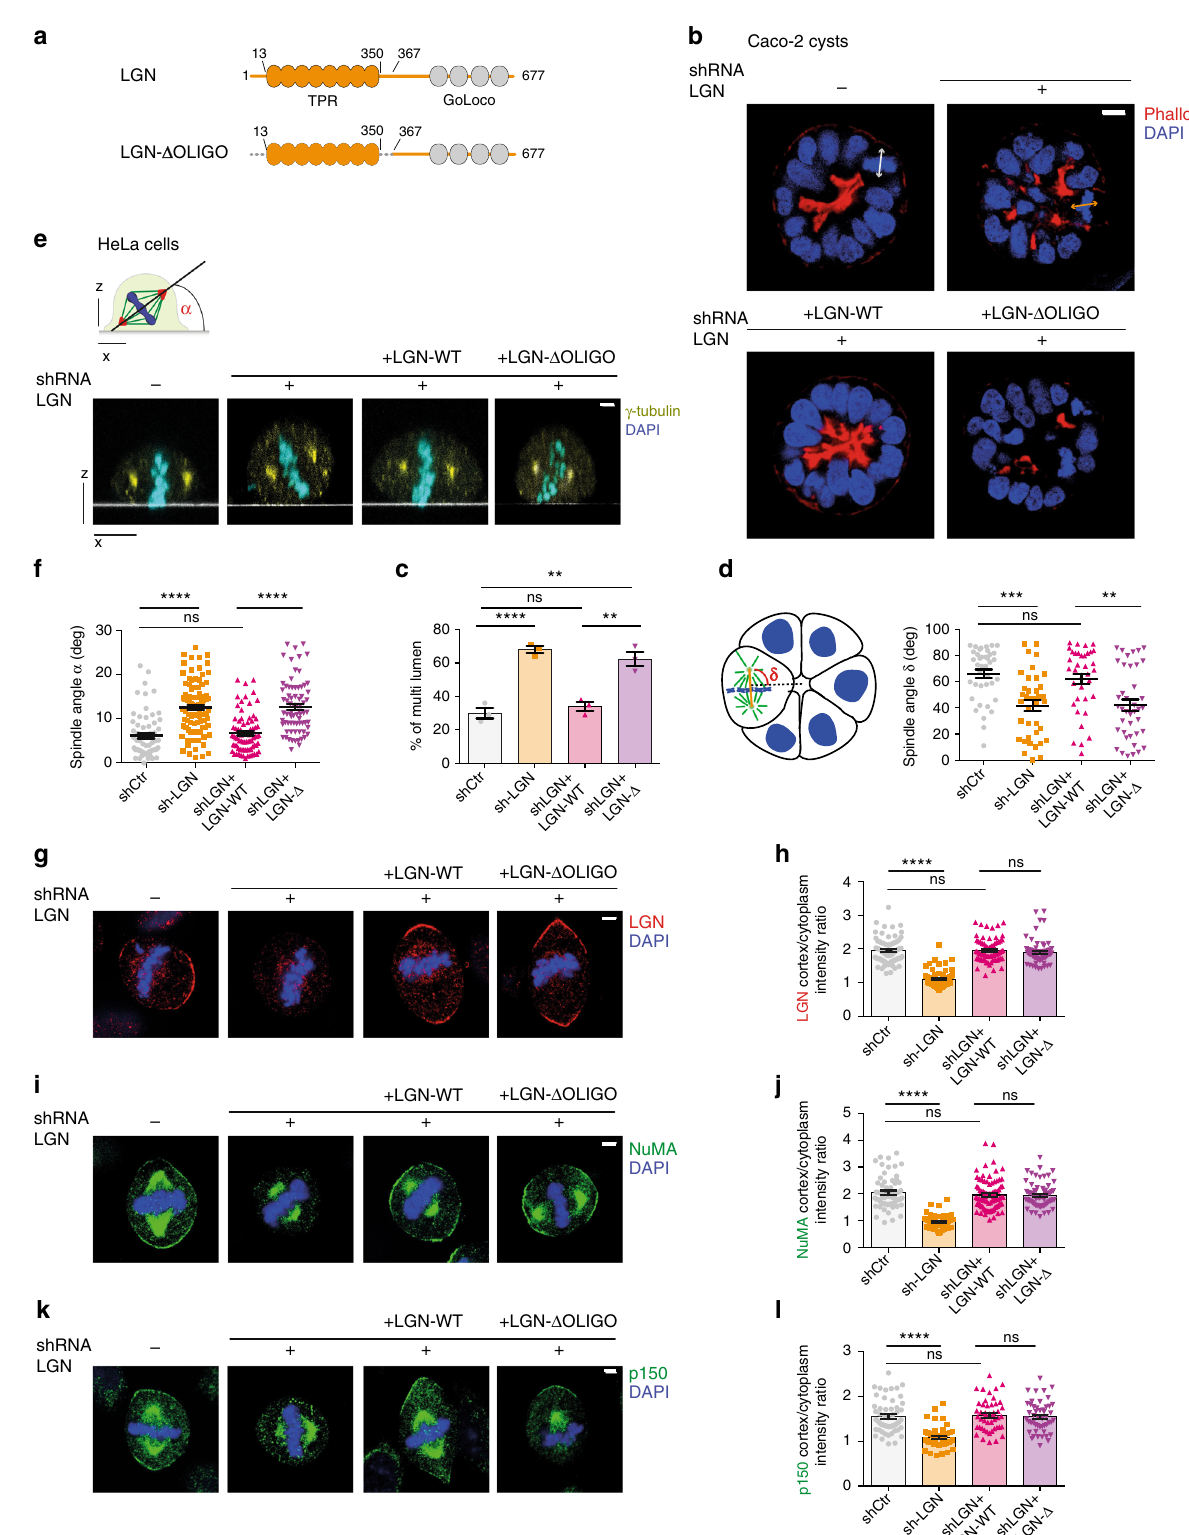
while cells lacking NuMA divide with a randomized orientation (Supplementary Fig. 4). Transient transfection of wild-type NuMA rescues misorientation defects, whereas transfection of NuMA- Δ OLIGO does not, similarly to what was observed with a NuMA mutant lacking the entire LGN-binding domain